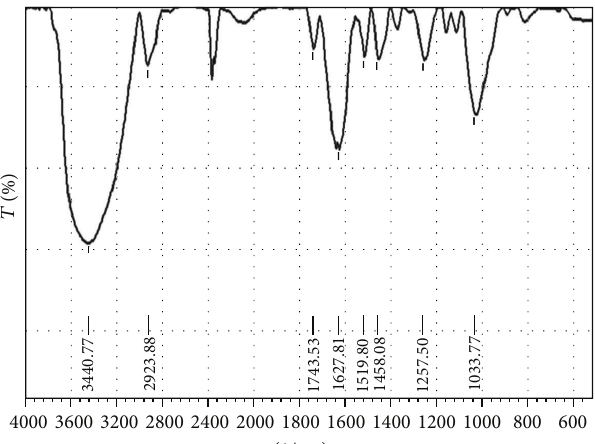
Figure 2: FT-IR spectra of palm tree male flower before MB